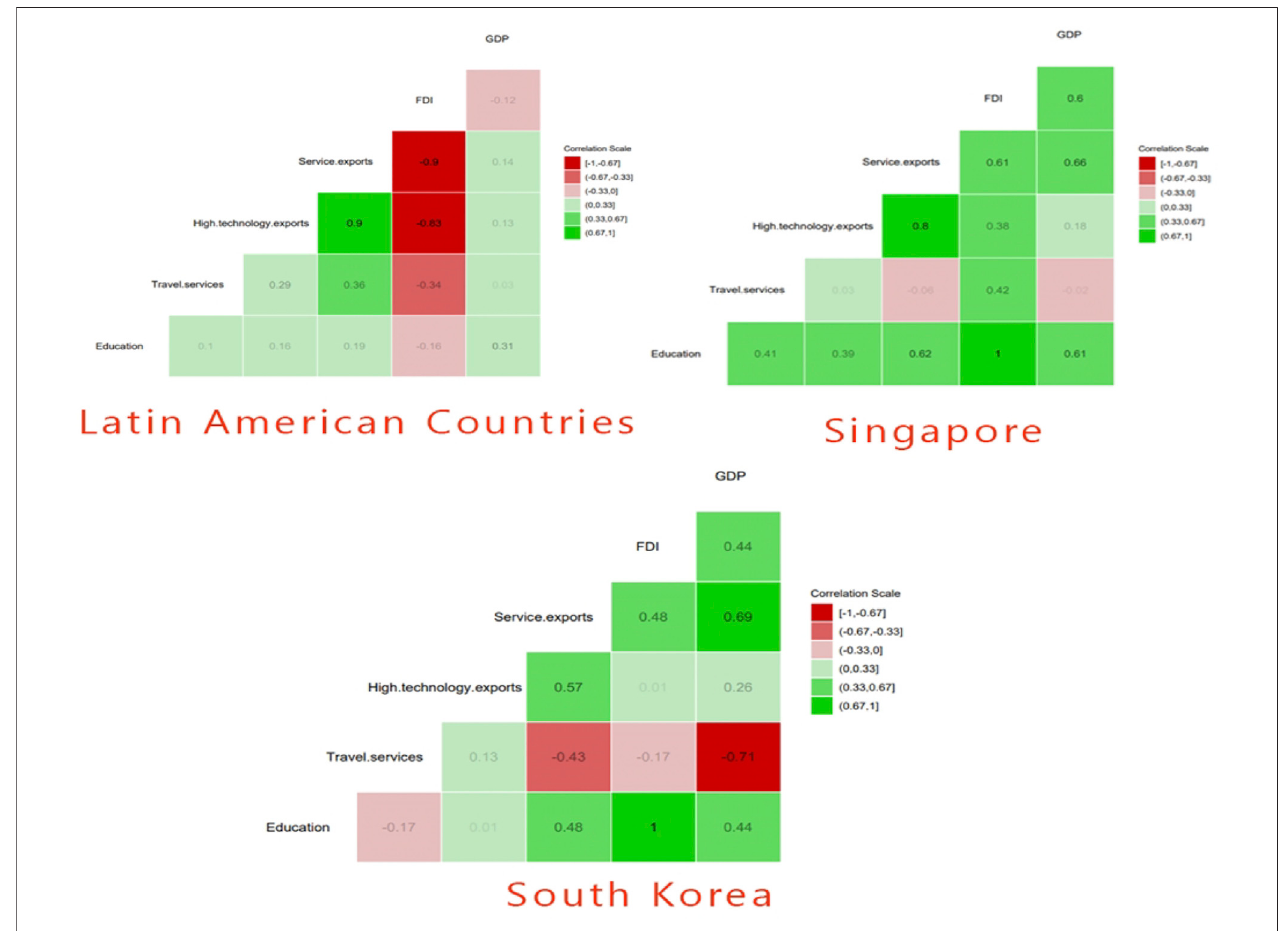
FIGURE 4 | Correlation analysis of different factors in different